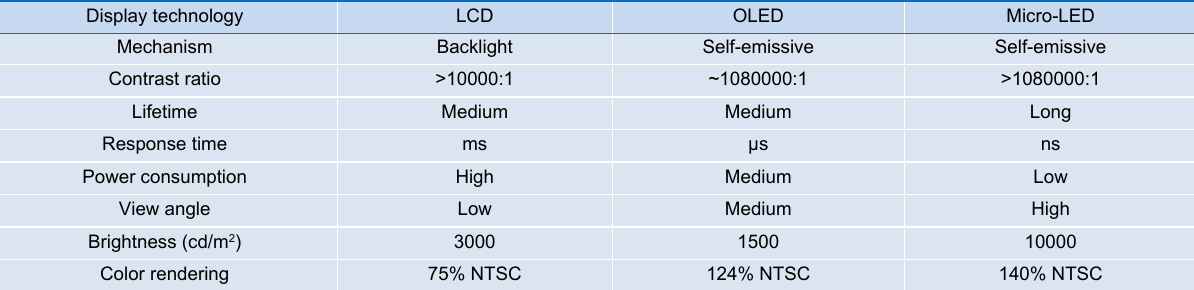
Table 1 | Performance comparisons of LCD, OLED and micro-LED